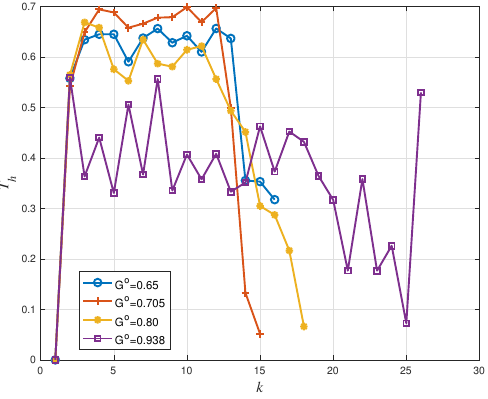
Figure 7. Throughput performance T h versus frame index k for IRSA with Λ ( x ) = 0.5 x 2 + 0.28 x 3 + 0.22 x 8 .